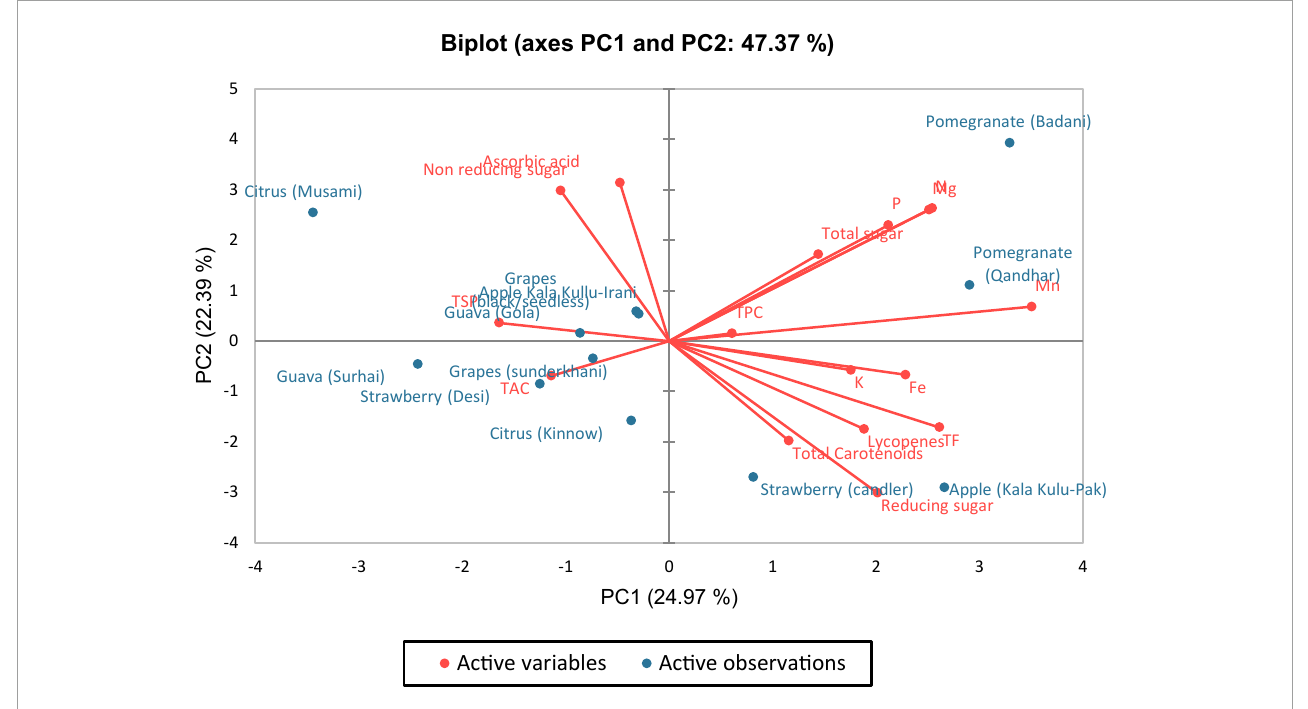
FIGURE1 Biplot of different fruit peels compounds for first two principal components.